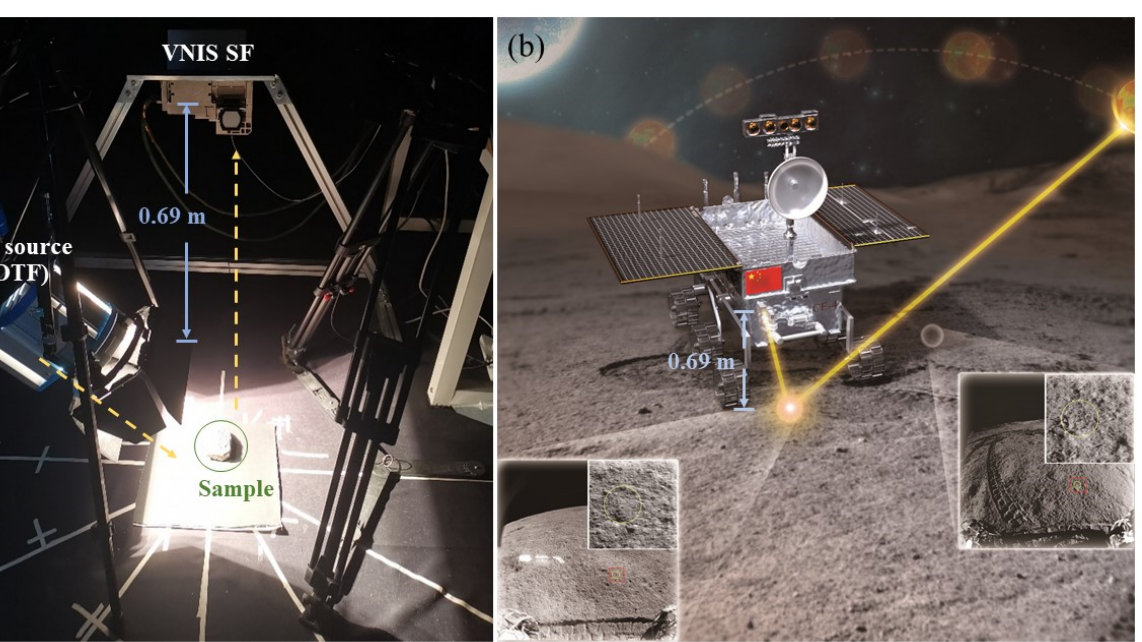
Figure 2. ( a ) The picture of the VNIS SF experiment condition. ( b ) The model picture of the detecting condition of VNIS on the lunar surface [17].